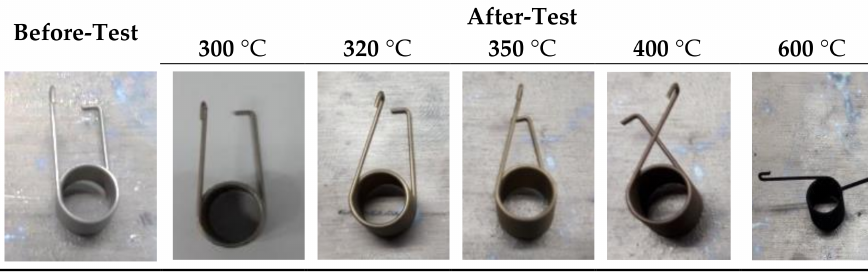
Figure 7. Degradation shapes of test samples at each temperature condition.